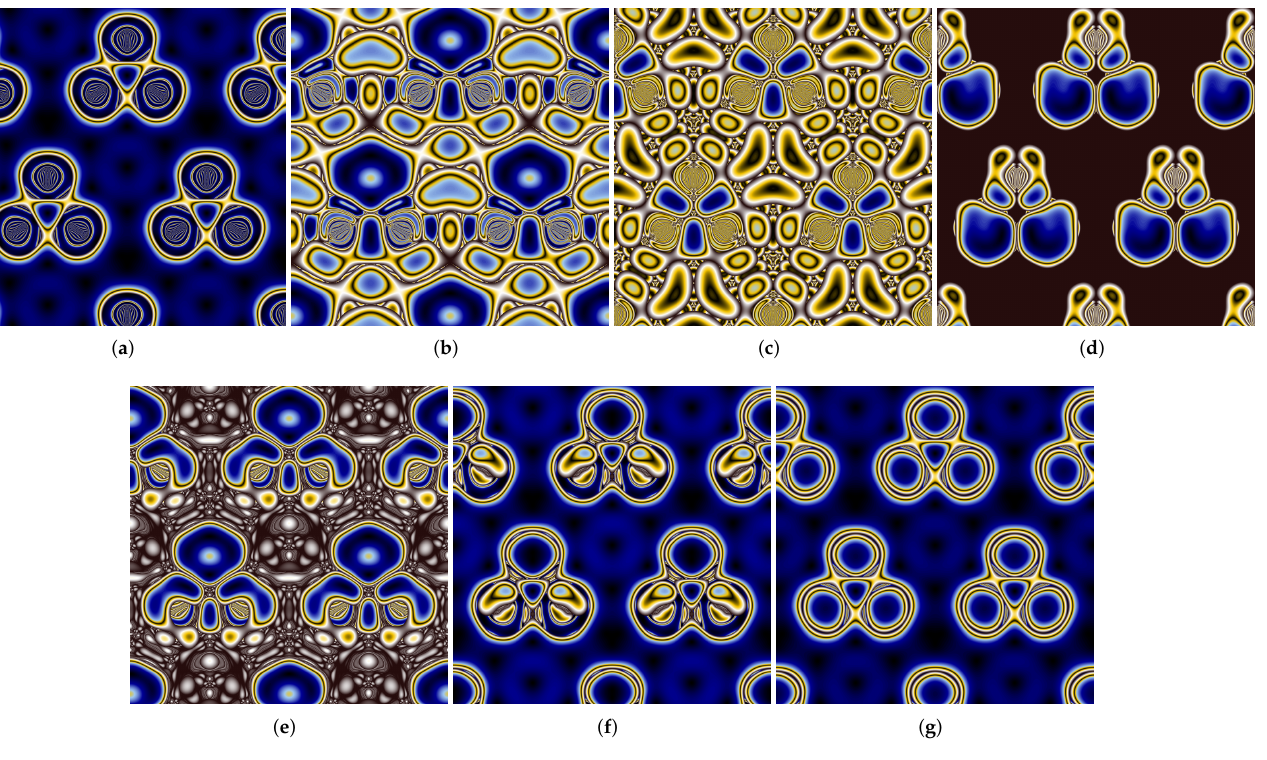
Figure 5. Patterns generated with function f with p3m1 symmetry and various orbit traps from Figures 1 and 3. ( a ) 1 orbit trap from Figure 1a; ( b ) 2 orbit traps from Figure 3a; ( c ) 3 orbit traps from Figure 1b; ( d ) 4 orbit traps from Figure 1c; ( e ) 4 orbit traps from Figure 3b; ( f ) 5 orbit traps from Figure 3c; and ( g ) 7 orbit traps from Figure